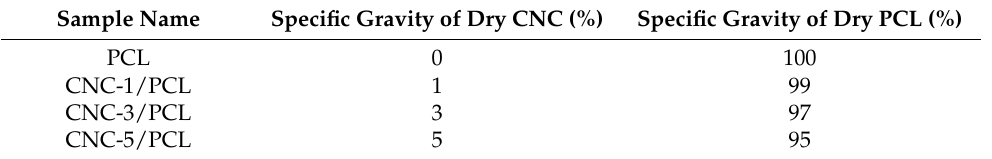
Table 1. Chemical compositions of samples2.2.2 Simulation Modeling of a different scaffold pattern.